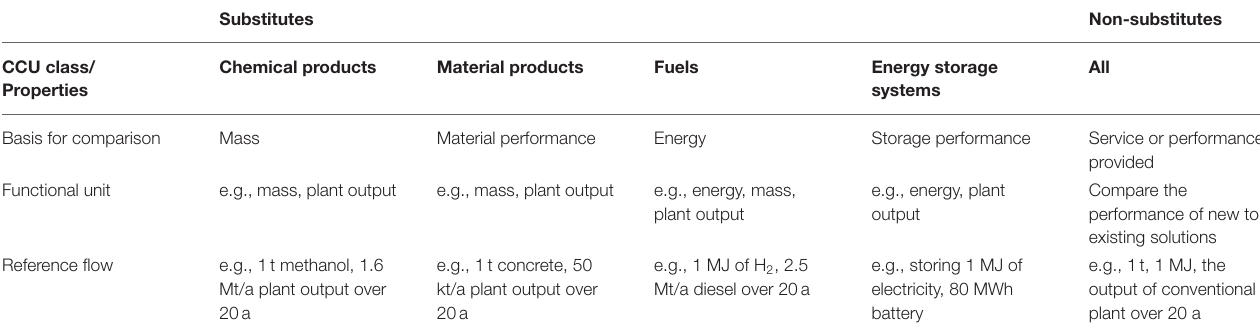
TABLE 3 | Examples of CCU substitutes, the basis of comparison, functional units and reference flows.